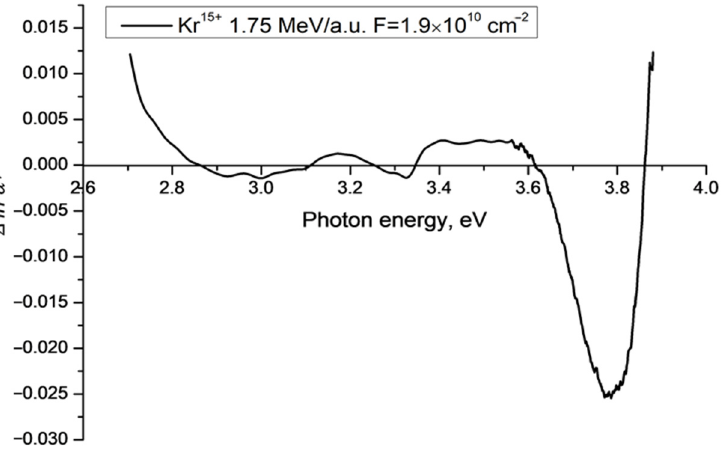
Figure 2. Difference function ∆ ln α * for a 12 µ m PET film sample on a cylindrical aluminum drum irradiated with Kr 15+ ions of energy 1.75 MeV/a.u. and a fluence of 1.9 × 10 10 cm − 2 in normal geometry [17]. The positive regions below 2.8 eV and above 3.9 eV correspond to the transition zones to other linear approximations as shown in Figure 1.